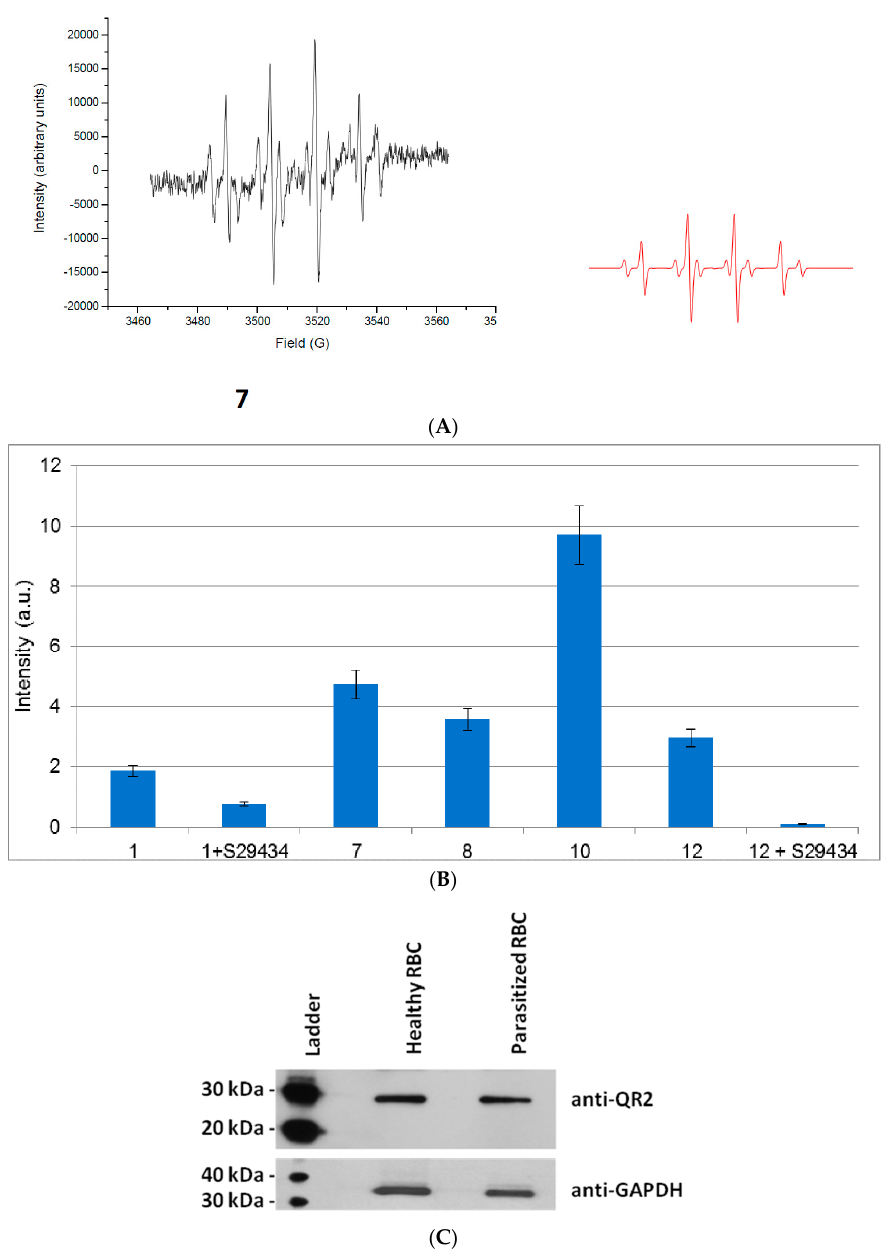
Figure 4. Free radicals produced by metabolization of indolone derivatives in red blood cells. ( A ) EPR spectra recorded (left) after adding 7 to red blood cells, compared to the simulated spectrum (right, in red); ( B ) Comparison of reactive oxygen species (ROS) production for compounds selected from the two sets of active series. Cells (5 × 10 6 ) in DPBS buffer were treated with an indolone derivative substrate (100 µM), N -benzyldihydronicotinamide BNAH (100 µM), and DMPO (50 mM) (6% DMSO in the final mix). ROS production was evaluated by double integration of the area under the peaks. In two cases, cells were pre-incubated with S29434 (20 µM) for 30 min before adding compounds 1 and 12 ; ( C ) Comparison of the expression of hQR2 expression in healthy versus parasitized red blood cells by western blot.